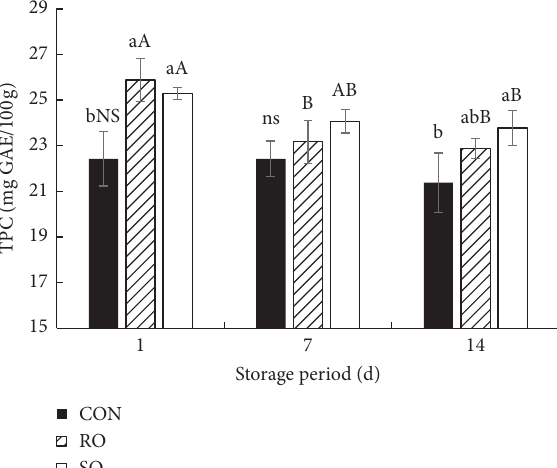
Figure 1: Changes in total polyphenol content (TPC) during storage of yogurt. CON: control; RO: raw omija; SO: sugared omija. Means with different superscripts (A, B in the same column and a, b in the same row) differ significantly ( P < 0 . 05). All values are represented as mean ± standard deviation for three replicates. NS: not significant.